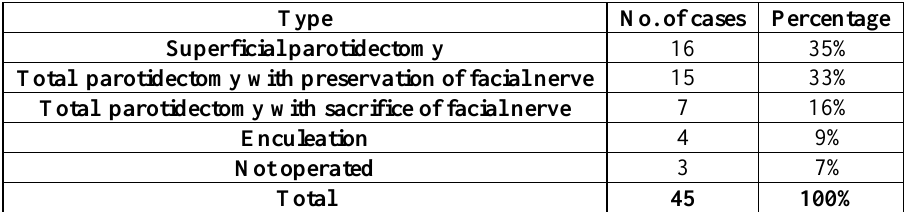
Table 4: Distribution of malignant parotid tumors